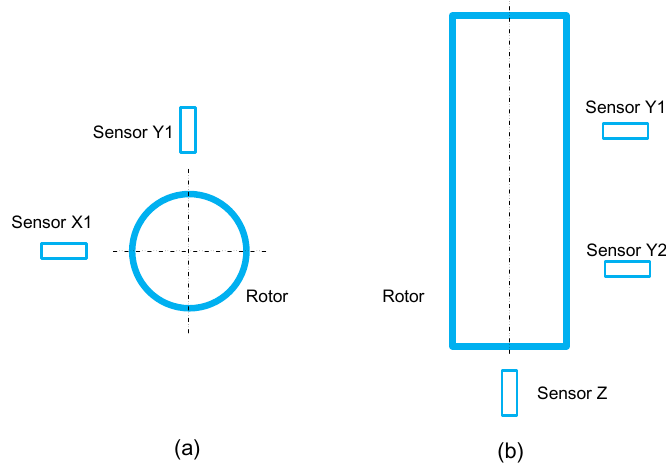
Figure 3. Placement of displacement sensors in an AMB–rotor system. ( a ) shows sensors arranged in one radial plane and ( b ) is a sensor arrangement distributed along the